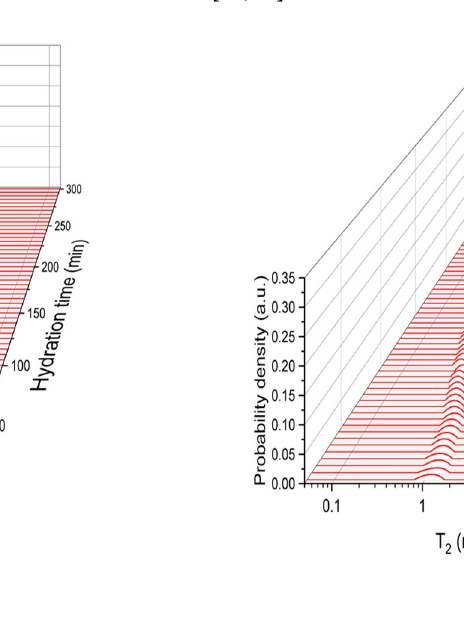
Figure 1. Relaxation time distributions of the two cement pastes during the early hydration: ( a ) the simple cement paste CP; ( b ) the cement paste prepared with 2% accelerator (CP + 2% Ca(NO 3 ) 2 ), by cement weight. The smaller peak corresponds to the embedded water while the larger peak corresponds to the capillary water.